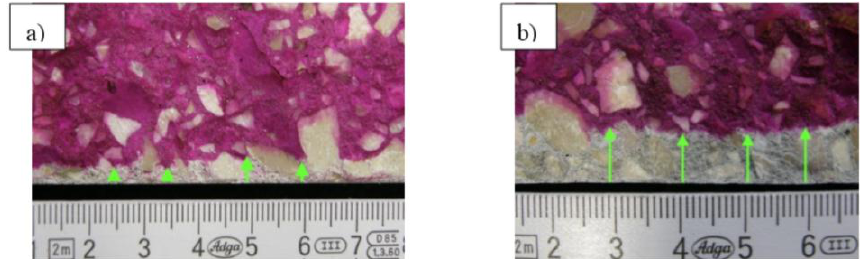
Figure 5. Freshly fractured concrete sprayed with phenolphthalein indicator solution after 56 days of exposition in 1% CO 2 , concrete with limestone aggregate: ( a ) CEM I; ( b ) CEM II/B-M(V-W).